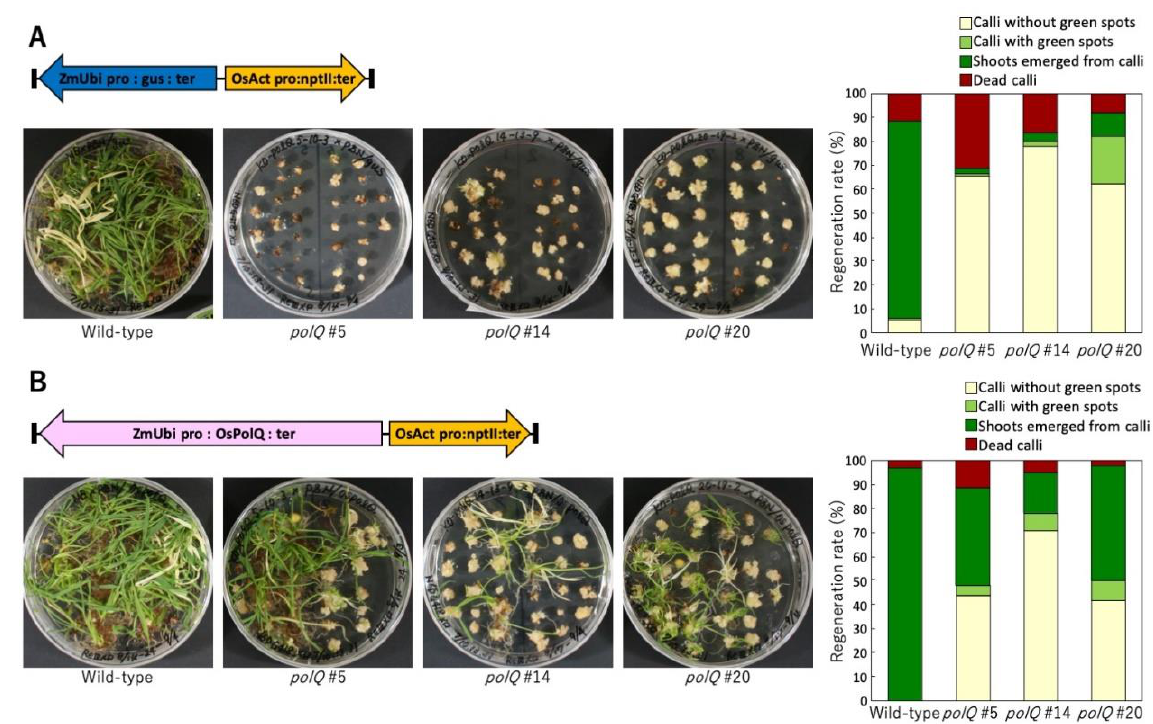
Figure 2. Regeneration of wild-type and polQ mutant rice plants after transformation by an Agrobacterium strain lacking or harboring a wild-type rice PolQ gene in the T-DNA. Transgenic calli (wild-type Nipponbare or three different polQ mutant lines (see [106]) were selected on medium containing 35 mg/L geneticin (G418) and 25 mg/L meropenem for four weeks. The calli were then transferred to regeneration medium (ReIII) lacking geneticin. Left panels, the plates were photographed after further incubation for four weeks. Right panels, the percentage of calli that developed shoots was quantified. ( A ) Infection by an Agrobacterium strain lacking a PolQ gene in the T-DNA. ( B ) Infection by an Agrobacterium strain containing a PolQ gene in the T-DNA. Data are from Dr. Ayako Nishizawa-Yokoi.